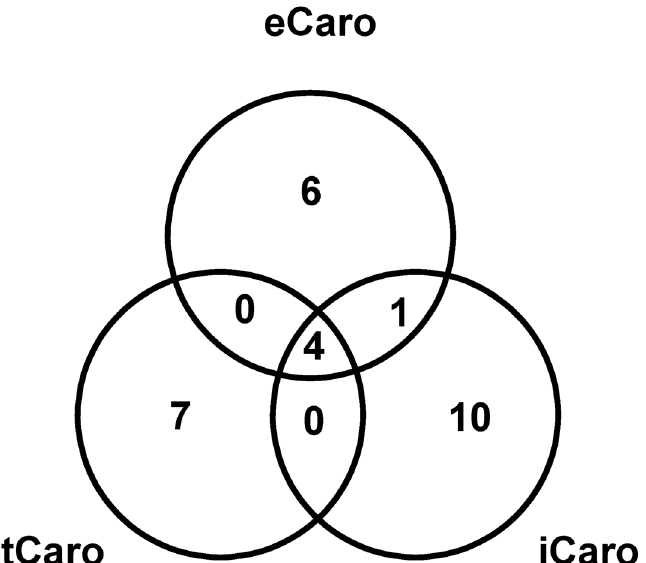
Fig 6. Venn diagram showing number of SNPs significantly associated with extractable carotenoid content (eCaro), wavelet transformed spectral reflectance carotenoid content (tCaro) and spectral index carotenoid content (iCaro) using MLM+Q+K